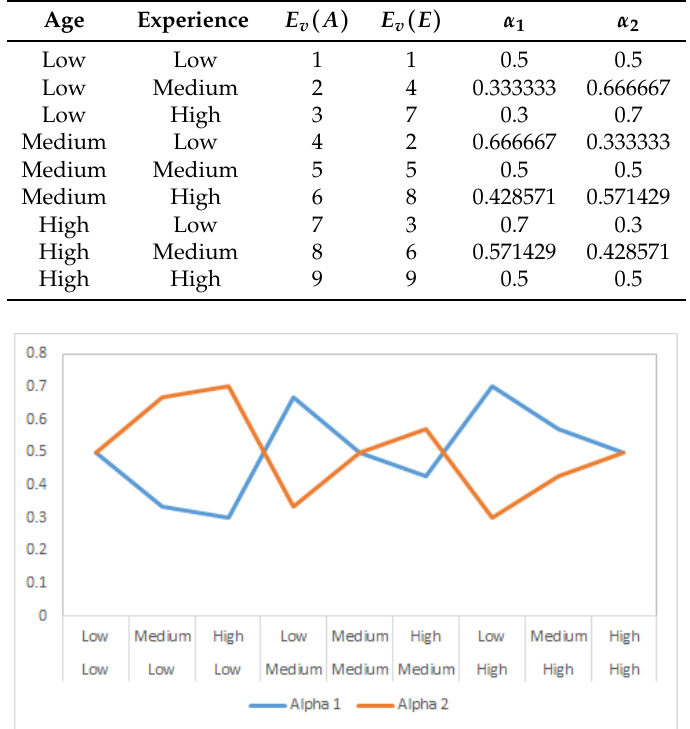
Table 5. Weight values for driver’s attitude.